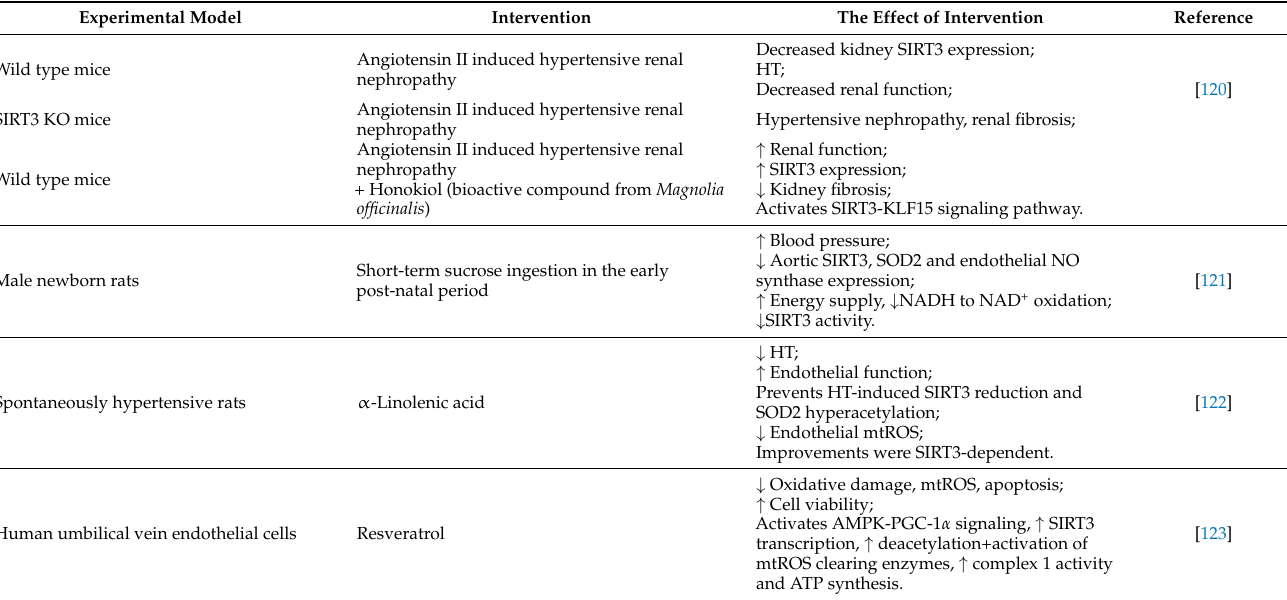
Table 1. Interventions that modulate SIRT3 signaling in hypertension.